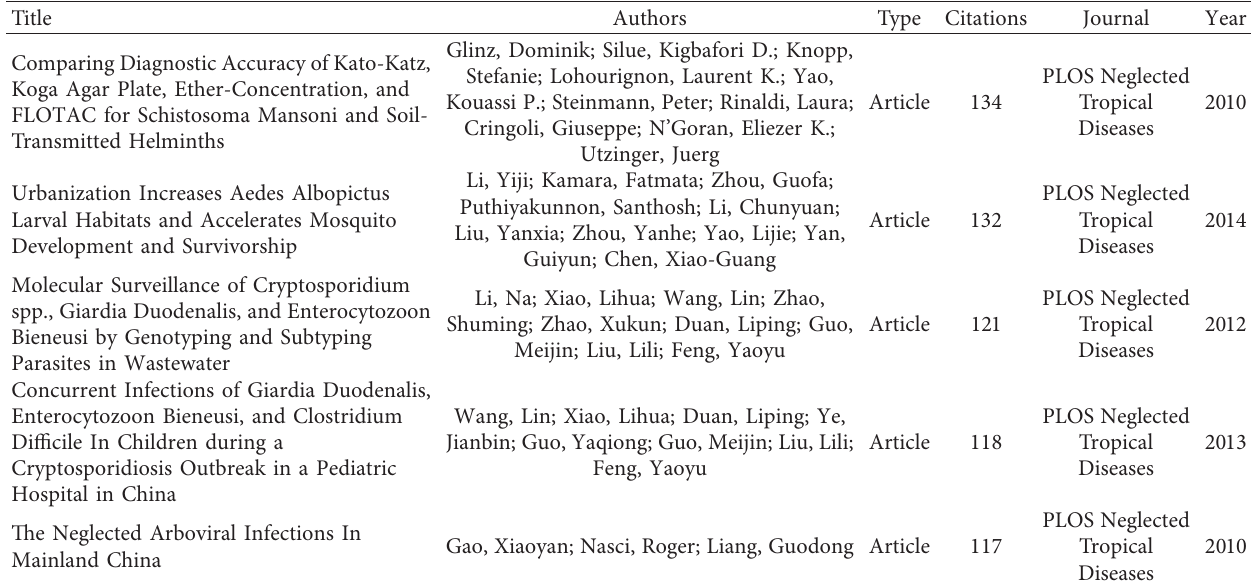
Table 3: The most cited articles in the field of tropical medicine,